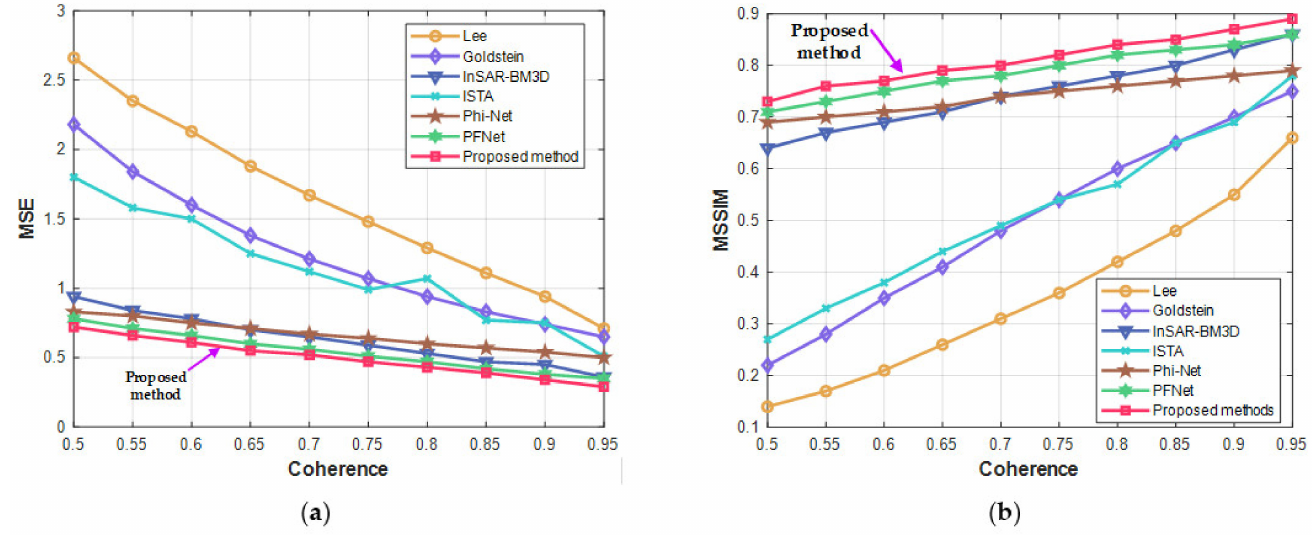
Figure 8. The metrics of the seven methods on the simulated interferograms with ten coherence coefficients: ( a ) mean MSE; ( b ) mean MSSIM.